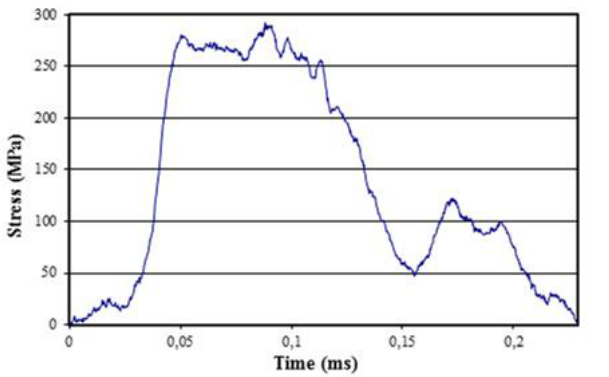
Figure 16. Stress wave relating to the classical SHTB (Model 1) at a pressure equal to 3.5bar.